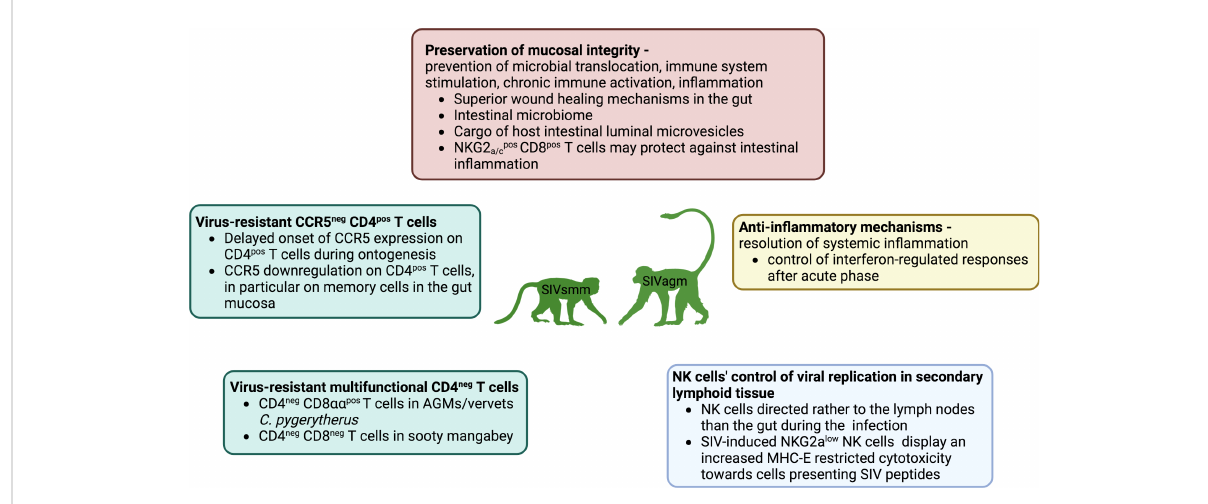
FIGURE 1 Mechanisms of protection against SIV infections include homeostatic regulation of immune cell populations through target cell restriction by downregulation of CD4 or CCR5 in T-cells (green frame) and NK cell colocalization in secondary lymphoid tissues, expansion and enhanced MHC-E restricted activity (blue frame), preservation of mucosal immunity, and thus prevention of microbial translocation, immune system stimulation and chronic immune activation. In fl ammation is undergirded by highly effective non-in fl ammatory wound healing in the intestinal mucosa, the anti-viral content of epithelial microvesicles in the gut, and a potential anti-in fl ammatory role of NKG2a/c + CD8 + T cells in the gut, while the role of the intestinal microbiome remains unclear (red frame), and systemic anti-in fl ammatory mechanisms control the expression of interferon-stimulated genes after the acute phase